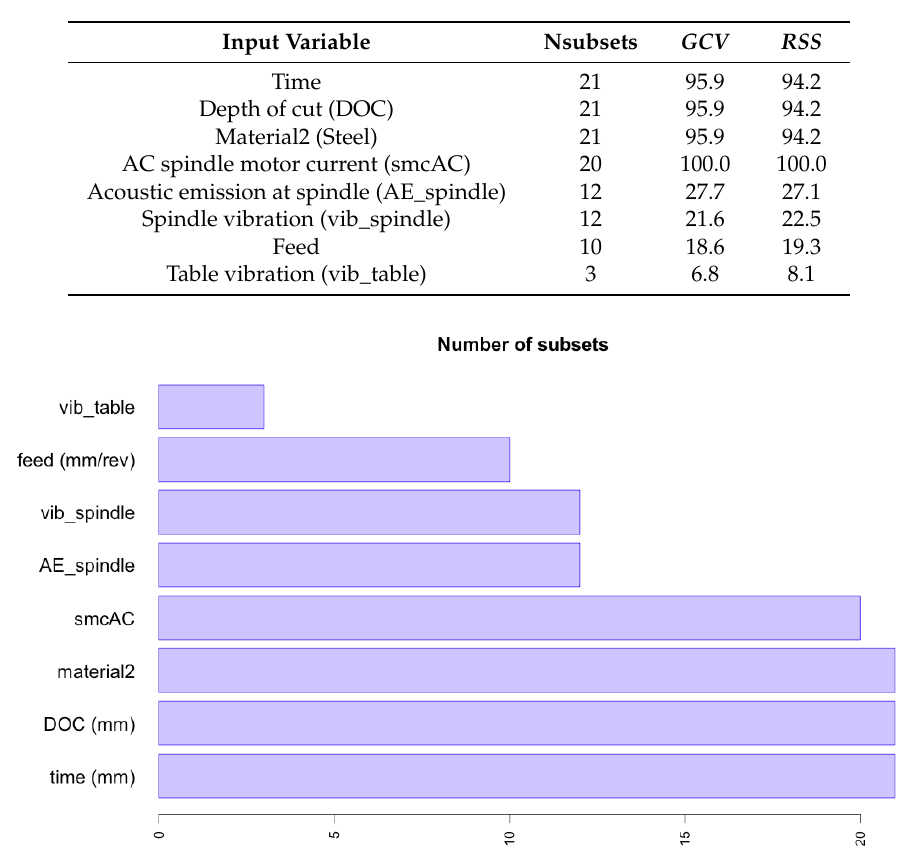
Table 8. Significance ranking for the variables involved in the best fitted ABC-MARS-based model for the tool flank wear (VB) prediction according to criteria Nsubsets, GCV, and RSS .